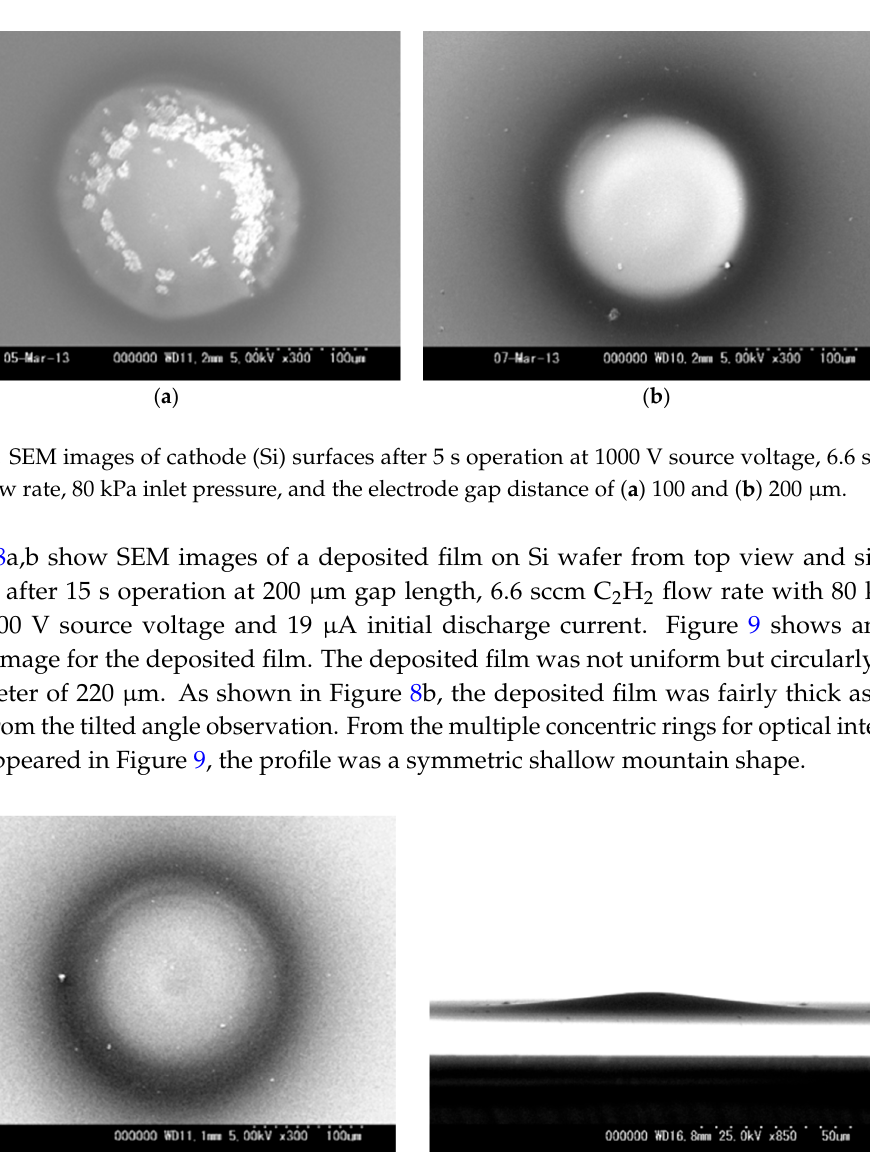
Figure 8. SEM image from ( a ) top view and ( b ) side view of deposited film after 15 s operation at 200 μ m gap length, 6.6 sccm C 2 H 2 flow rate with 80 kPa inlet pressure, and 1000 V source voltage.